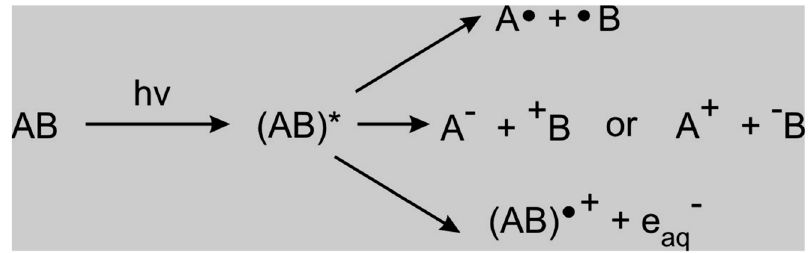
Figure 16. Possible scenarios of events indirect